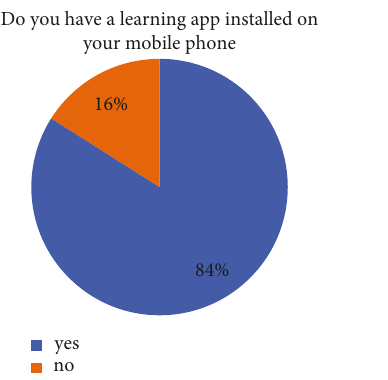
Figure 12: Survey on apps installed on students’ cell phones for learning.